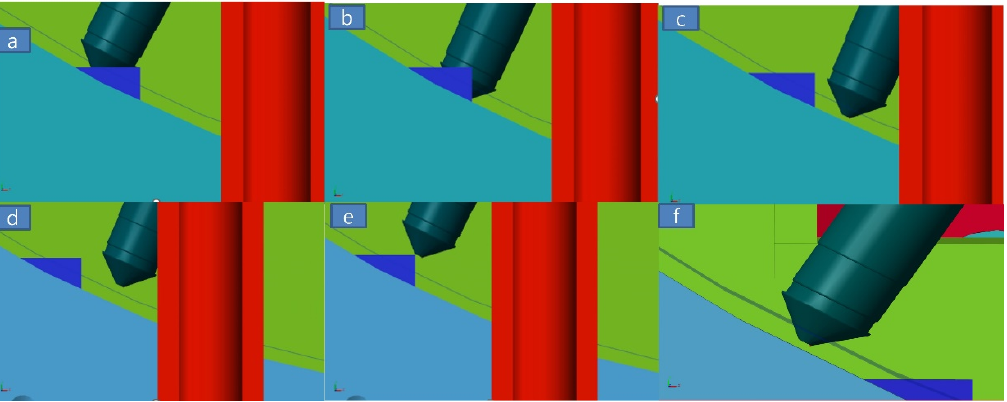
Figure 17. Solid obstacle avoidance in simulator (end-effector). ( a – c ) Collision detection (scanning). ( d – f ) Collision avoidance after scanning and saving obstacle position (on return).